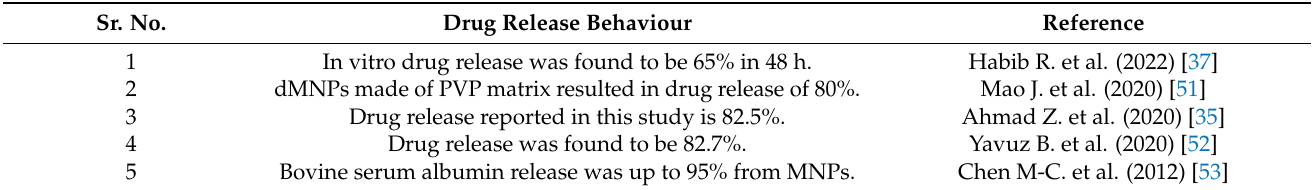
Table 5. Kinetic modelling of release data.